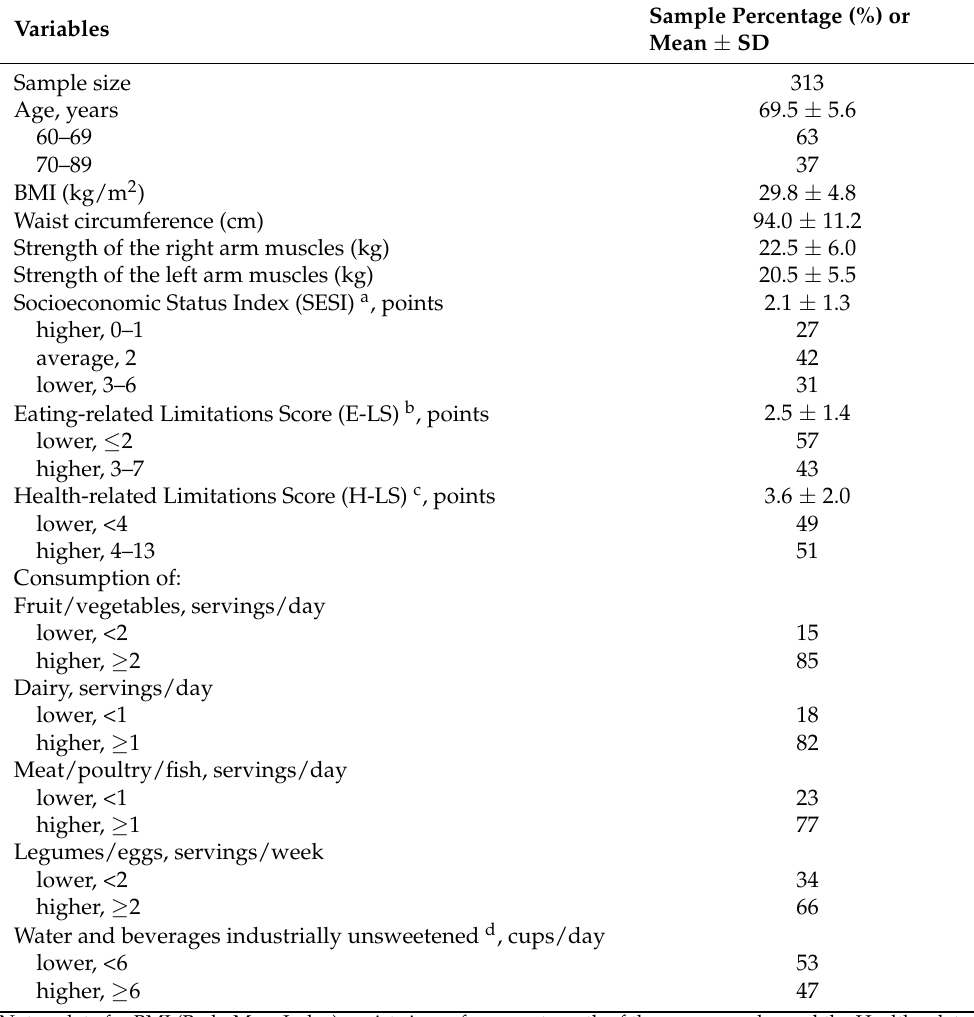
Table 4. Study sample